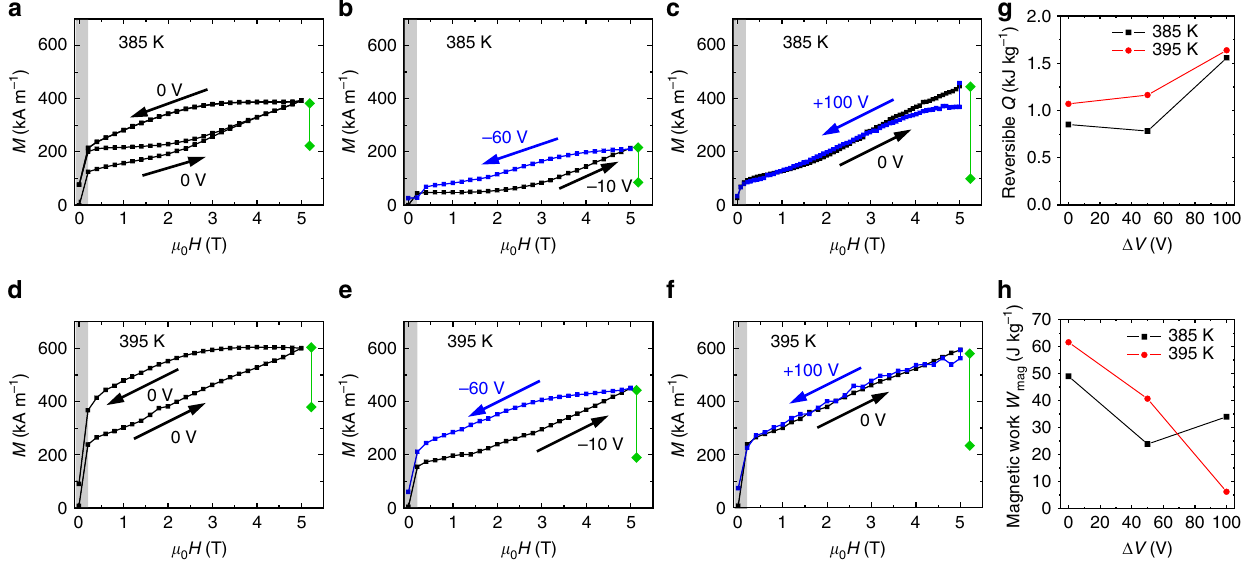
Figure 2 | Isothermal magnetic measurements. ( a – f ) Experimental magnetization versus magnetic field curves during isothermal ( a , d ) magnetic, ( b – c , e – f ) magnetic-electric cycles at ( a – c ) 385K and ( d – f ) 395K. In ( a ), the remagnetization curve after a full cycle is also shown. The grey shaded region ( m 0 H o 0.25T) is dominated by rearrangement of ferromagnetic domains. Diamond-headed green markers indicate the reversible magnetization change D M achieved in each cycle. ( g ) Reversible isothermal heat Q and ( h ) magnetic work done, versus the change in voltage D V at m 0 H ¼ 5T.